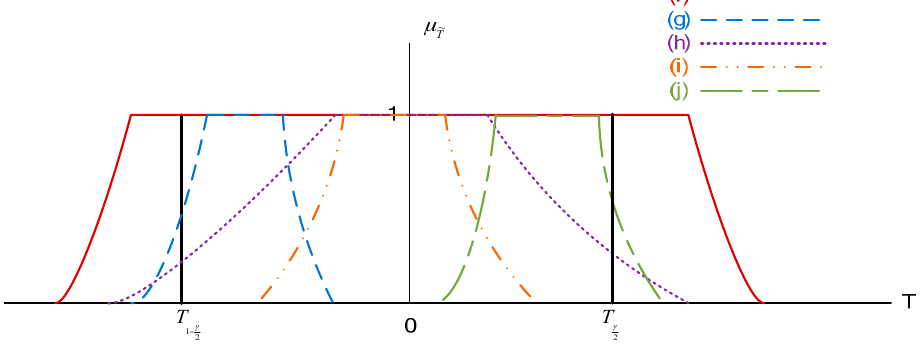
~ ~ ~ for the two-sided test. for the two-sided test. for the two-sided test.